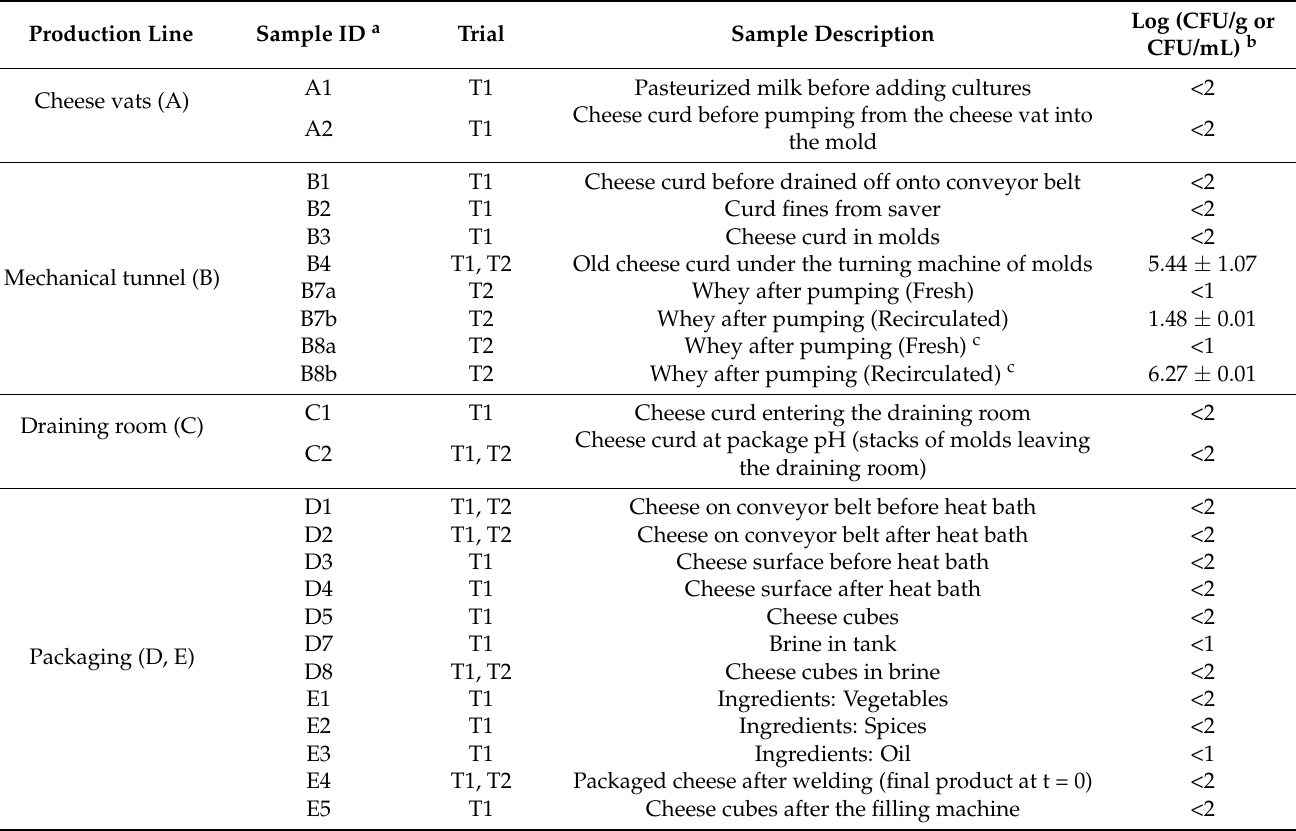
Table 1. Viable counts of yeasts in milk, whey, and cheese samples from white-brined cheese production.